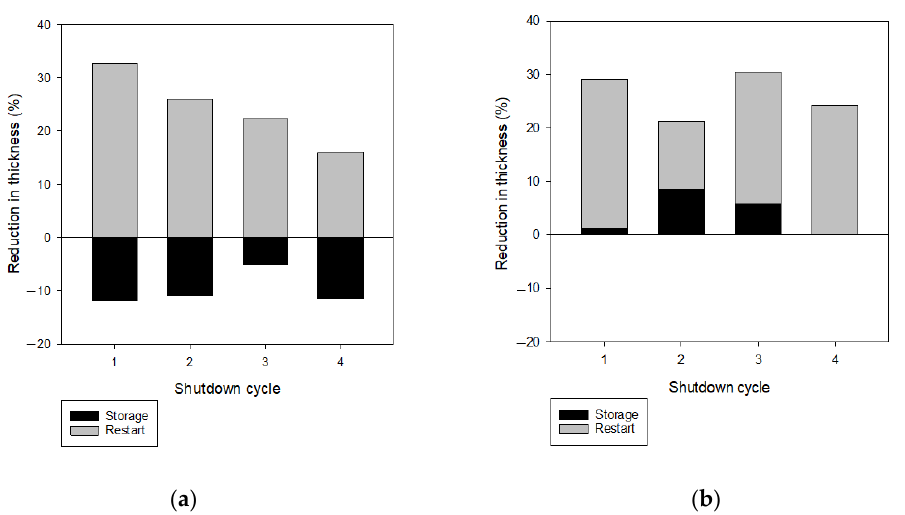
Figure 11. Analysis of the reduction in foulant layer thickness during intermittent operation. ( a ) RO operation with membrane storage in the feed water (Case 2). ( b ) RO operation with the membrane storage in DI water (Case 3).